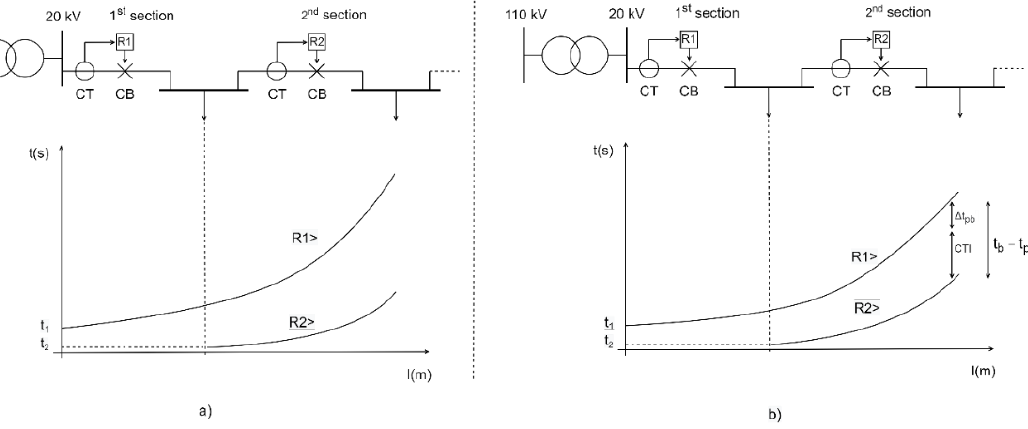
Figure 3. The difference between an OF with: ( a ) one goal and with ( b ) two simultaneous goals.